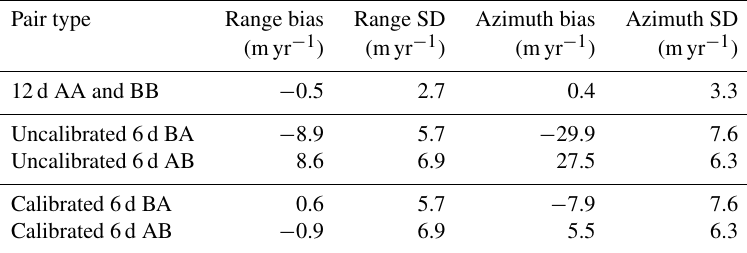
Table 3. Velocity biases for different satellite